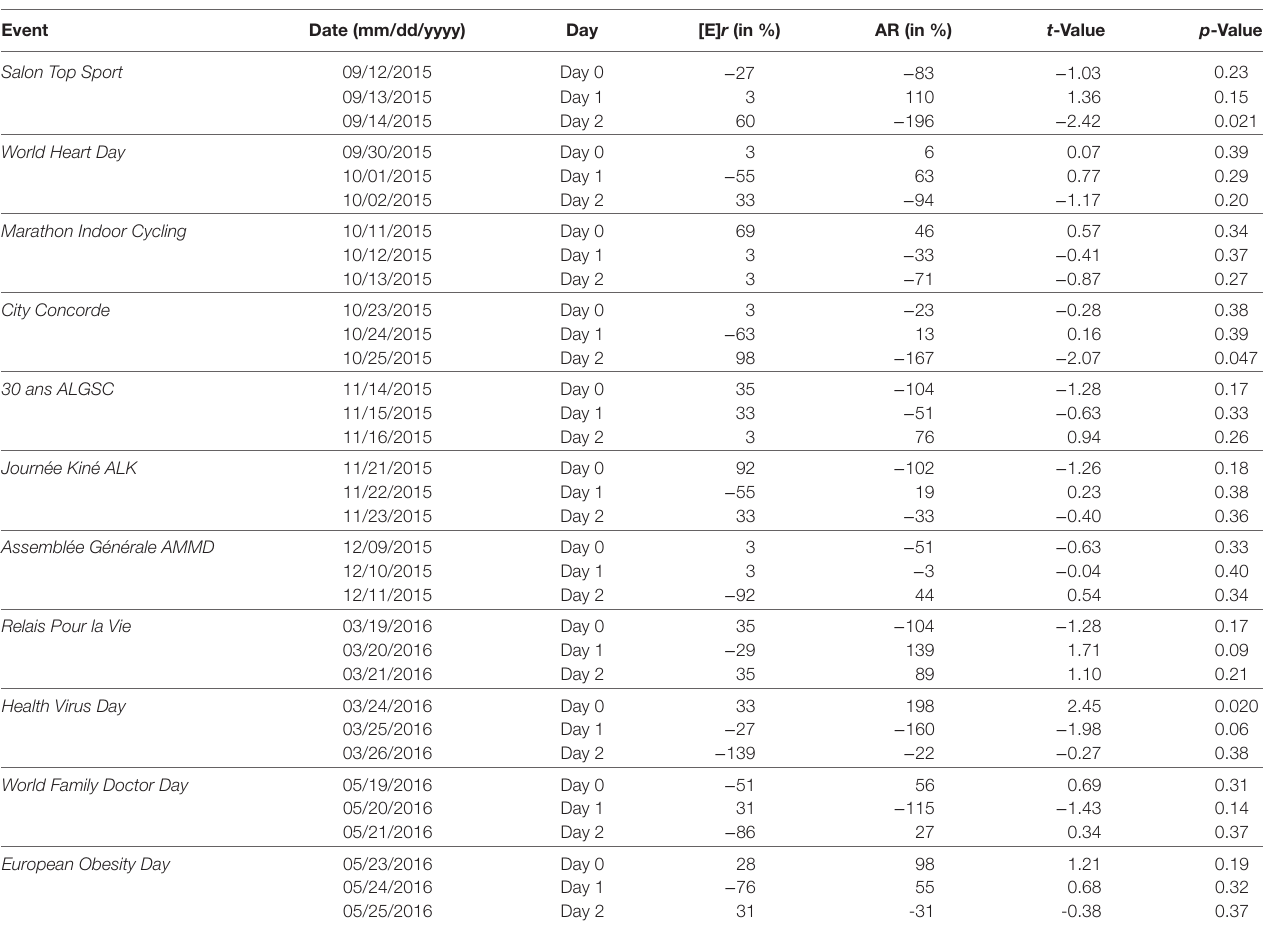
TaBle 3 | expected return ([e] r ) and abnormal return (ar) for each booth and the 2 days following each event.